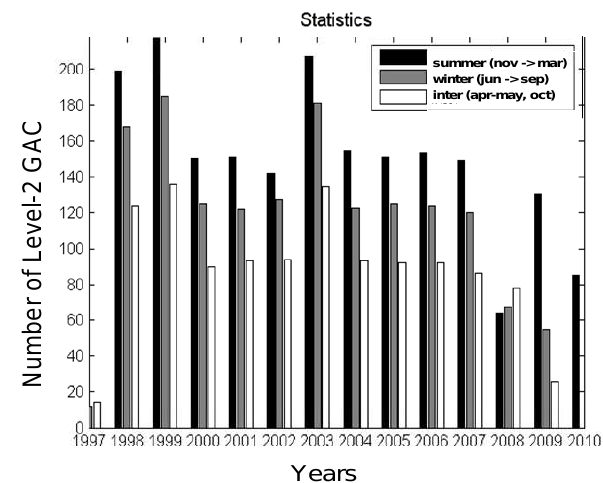
Fig. 5. Statistics of the number of SeaWiFS Level2 GAC im- ages used to determine the spatio-temporal distribution of Tri- chodesmium accumulations in the SP between 1997 and 2010 by year and season. Seasons are defined as: austral summer (Novem- ber to March); austral winter (June to September); interseason (April–May and